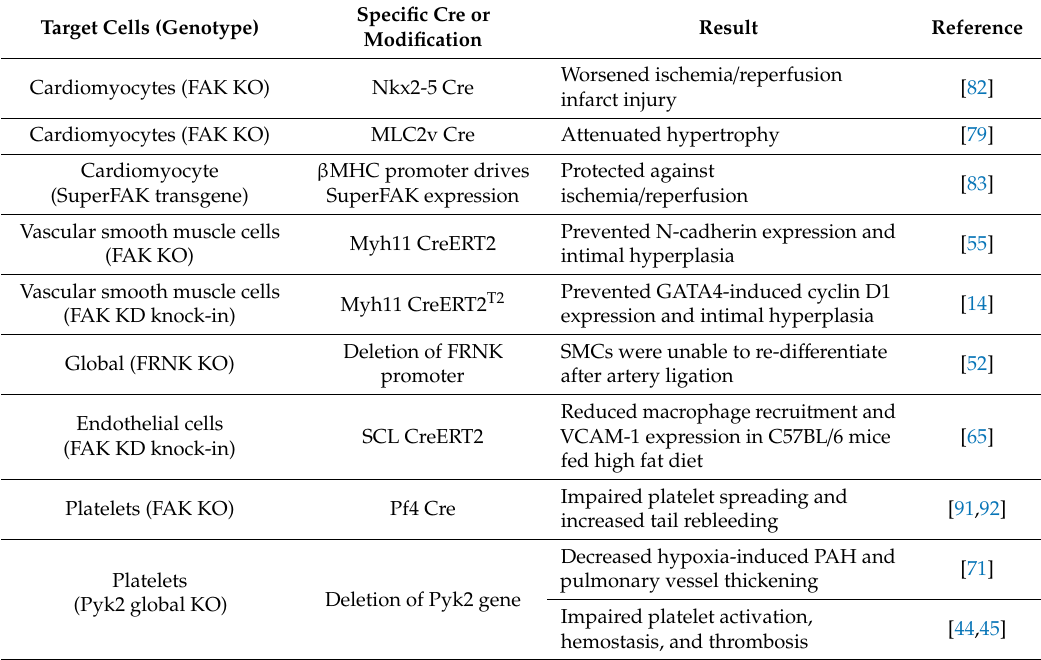
Table 2. Genetic FAK and Pyk2 mouse models to study vascular disease. Target Cells